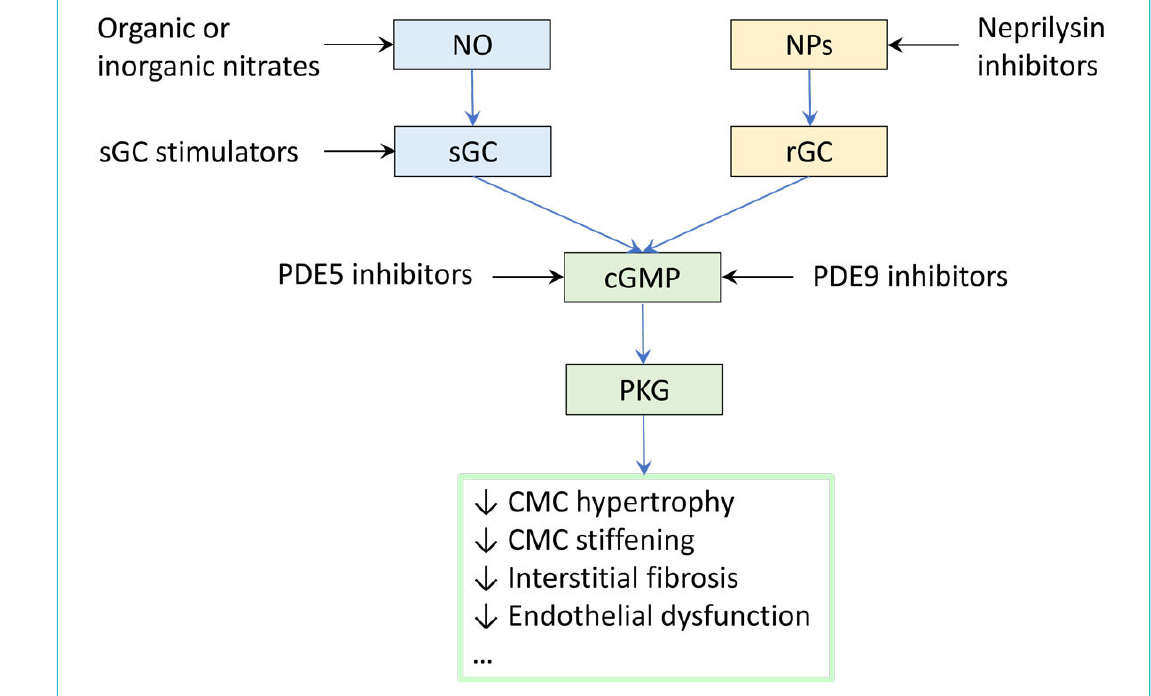
Figure 3: The NO-cGMP-PK axis as a potential therapeutic target in HFpEF. Intracellular cGMP may be maintained through the action of nitric oxide (NO)-mediated activation of soluble guanylate cyclase (sGC), through direct stimulation of sGC or through inhibition of the phosphodi- esterase-(PDE) mediated degradation. Alternatively, natriuretic peptides (NPs) induce cGMP through activation of the receptor guanylate cy- clase (rGC). PKG: protein kinase G; CMC: